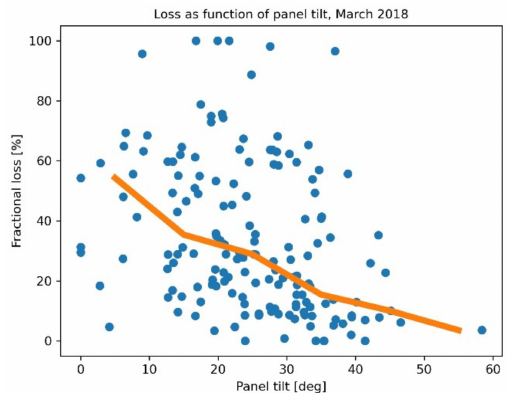
Figure 10. Snow loss during March 2018 as a function of panel tilt angle. Blue dots indicate losses for each of 161 individual sites as a fraction of the modeled snow-free production. The orange line shows the median value for each 10-degree